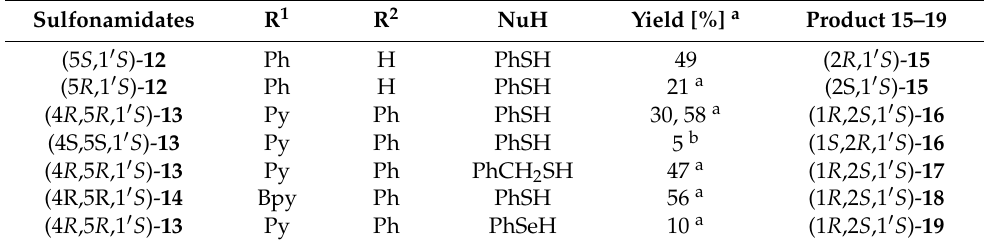
Table 1. Ring-opening reactions of cyclic